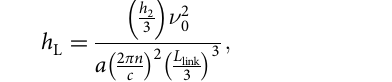
Fig. 3 the data are high-pass fi ltered with a cut-off frequency of 1 mHz to decouple link noise from ultrastable laser behaviour